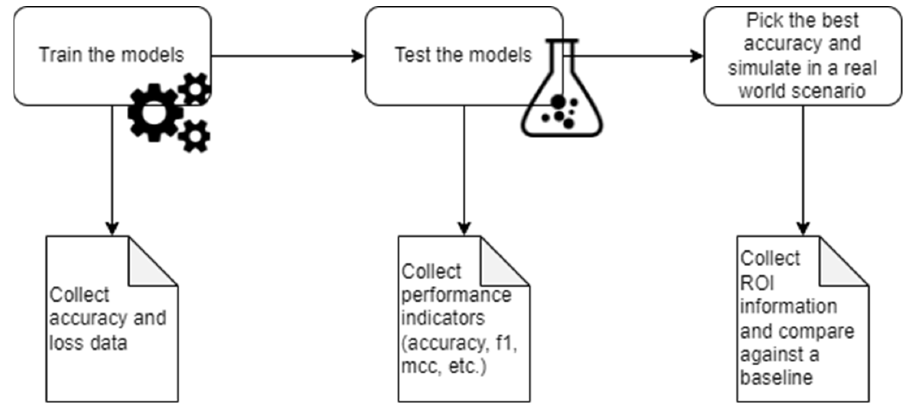
Figure 13. Experimentation methodology.